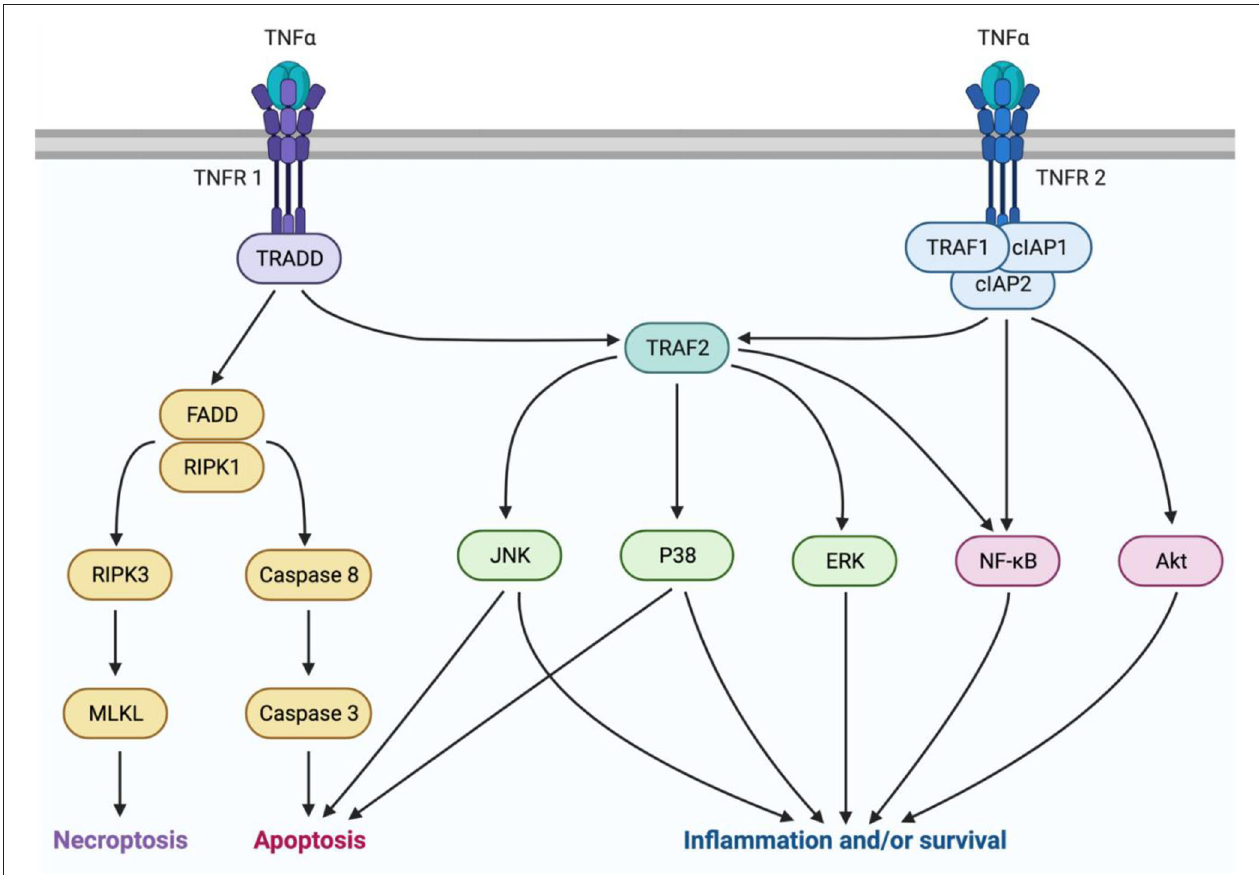
FIGURE 1 | TNF α signaling is mediated by two isoforms of the cytokine and two receptor subtypes. sTNF α can interact with TNFR1 to mediate either pro-inflammatory or pro-death signaling. Pro-death signaling occurs through recruitment of FADD and RIPK1, which can either lead to necroptosis trough RIPK3 and MLKL activation, or apoptosis through caspase8 and caspase 3 activation. Pro-inflammatory signaling occurs through TRAF2 activation of P38, JNK, or ERK MAPKs, or NF κ B. Alternatively, tmTNF α can interact with TNFR2 to mediate pro-homeostatic or pro-inflammatory signaling through TRAF1, cIAPs 1 and 2, and TRAF2.